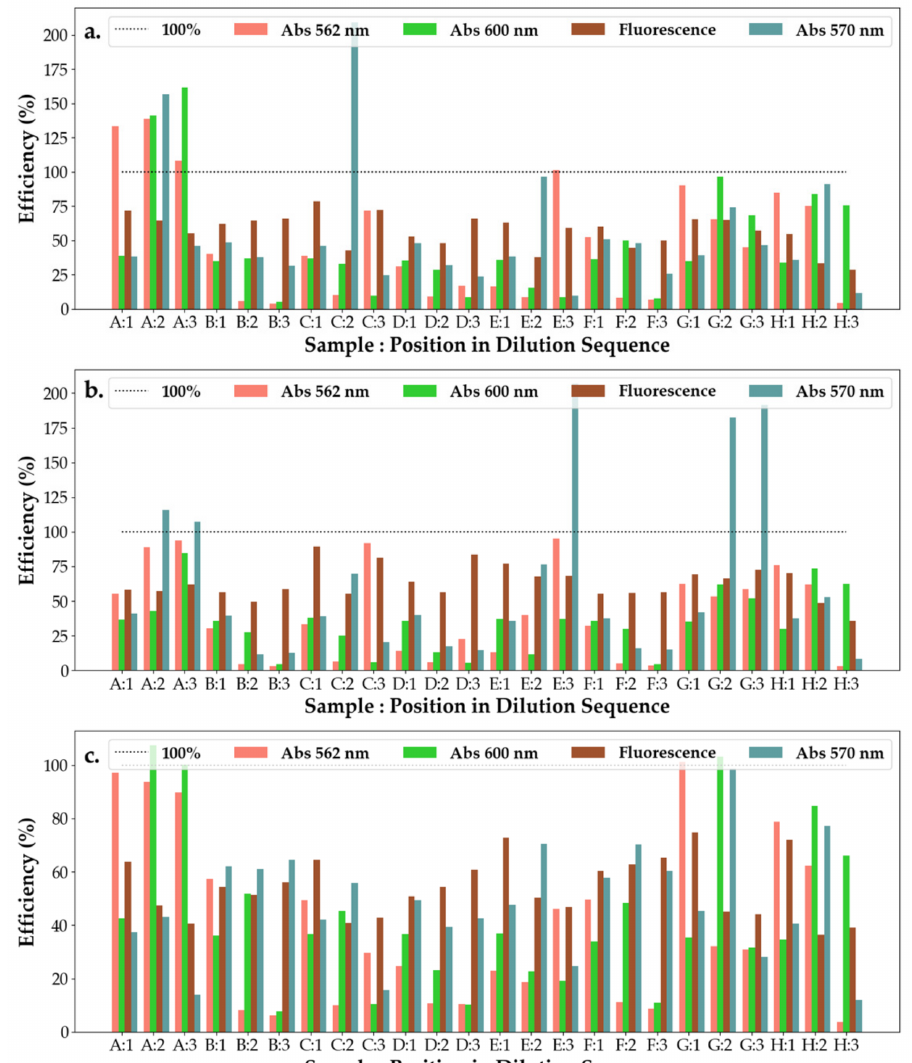
Figure 10. Efficiency of the antibacterial response ( η ) of the SAgNP-WT hydrogel samples at three levels of dilution tested against ( a ) Escherichia coli , ( b ) Pseudomonas aeruginosa and ( c ) Staphylococcus aureus . Samples A–H represent the following solutions tested against the bacteria: A—hydrogel control; B—AgNO 3 + PVP + PEG; C—hydrogel A, D—AgNO 3 + PVP + Gly; E—hydrogel B; F— AgNO 3 + PEG + Gly; G—hydrogel C; and H—AgNO 3 1N, as also shown in Figure